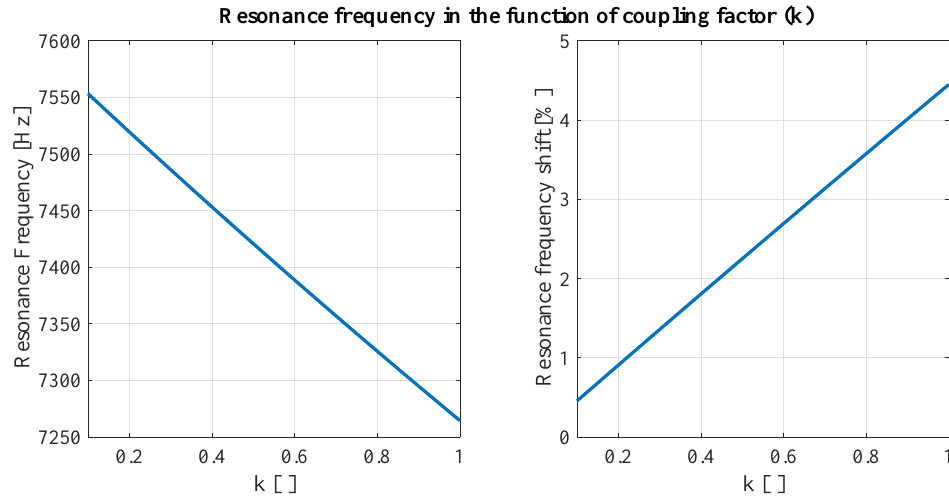
Figure 12. Impact of coupling factor ( κ ) on the resonance frequency in an exemplary HV